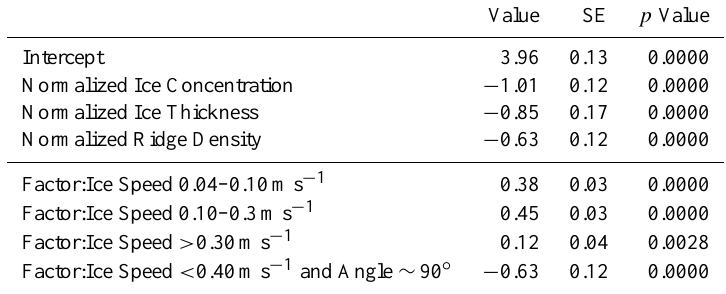
Table 1. Summary of the parameters obtained by fitting the mixed-effect model.